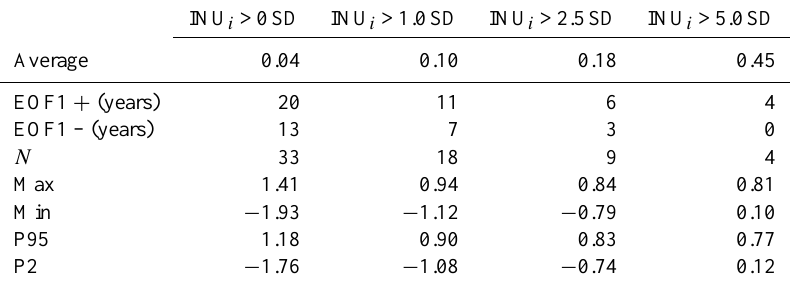
Table 1. Principal statistical parameters of EOF1 for each of the categories of the flood damage index INU whose thresholds were defined according to the standard deviation